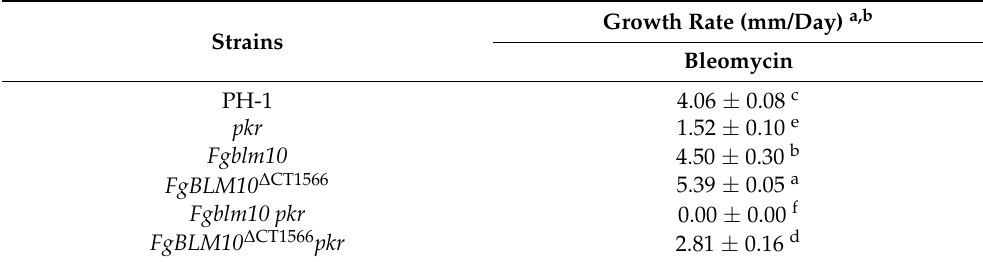
Figure 9. Deletion of the C-terminus of FgBLM10 enhances the resistance to bleomycin. Three-day-old PDA cultures of the wild-type PH-1, pkr mutant, Fgblm10 mutant, FgBLM10 ∆ CT1566 mutant, Fgblm10 pkr double mutant, and FgBLM10 ∆ CT1566 pkr double mutant in the presence or absence of 40 µg/mL bleomycin. Table 5. Growth phenotypes of the FgBlm10 mutant and its transformant strains treated with bleo- mycin.